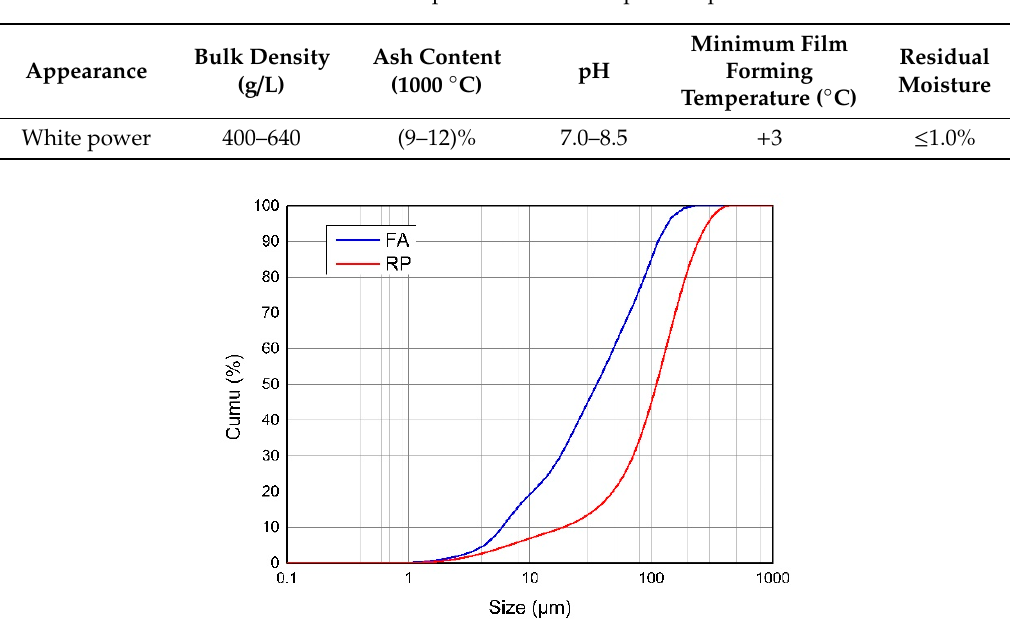
Figure 2. Particle size distribution of fly ash (FA) and RP.